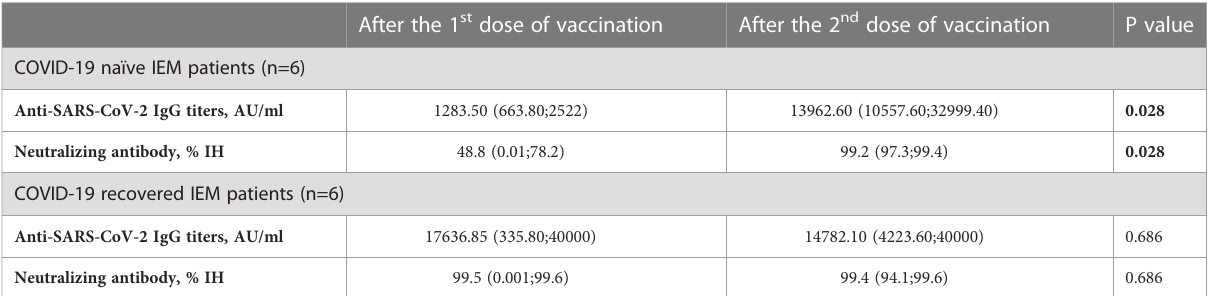
TABLE 5 Evaluation of Anti-SARS-CoV-2 IgG titers and neutralizing antibody IH% activity between the fi rst and second dose of BNT162b2 vaccination in patients with inborn errors of metabolism. After the 1 st dose of vaccination After the 2 nd dose of vaccination P